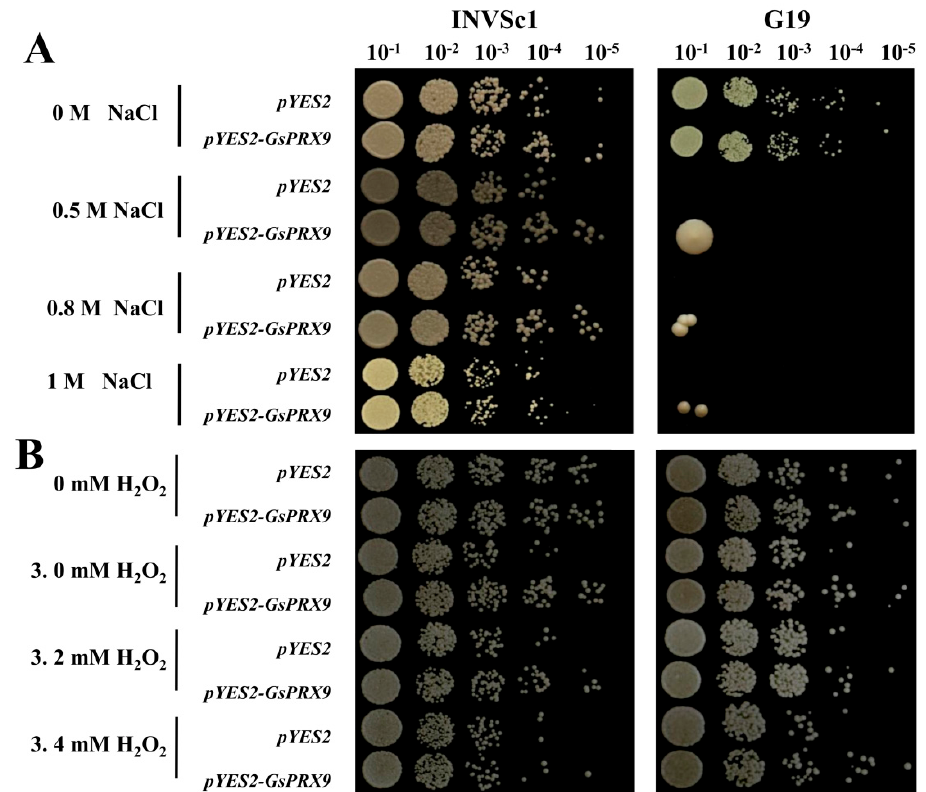
Figure 3. Effect of GsPRX9 overexpression on the tolerance of yeast strains of INVSc1 and G19 to salt ( A ) and H 2 O 2 ( B ) stress. pYES2 represents the yeast with empty vector and pYES2– GsPRX9 represents the yeast overexpressing GsPRX9 . Photos were taken after 72 h of incubation at 30 °C. The dilution rates of YPD medium containing the yeast transformants were 10 − 1 , 10 − 2 , 10 − 3 , 10 − 4 , and 10 − 5 .